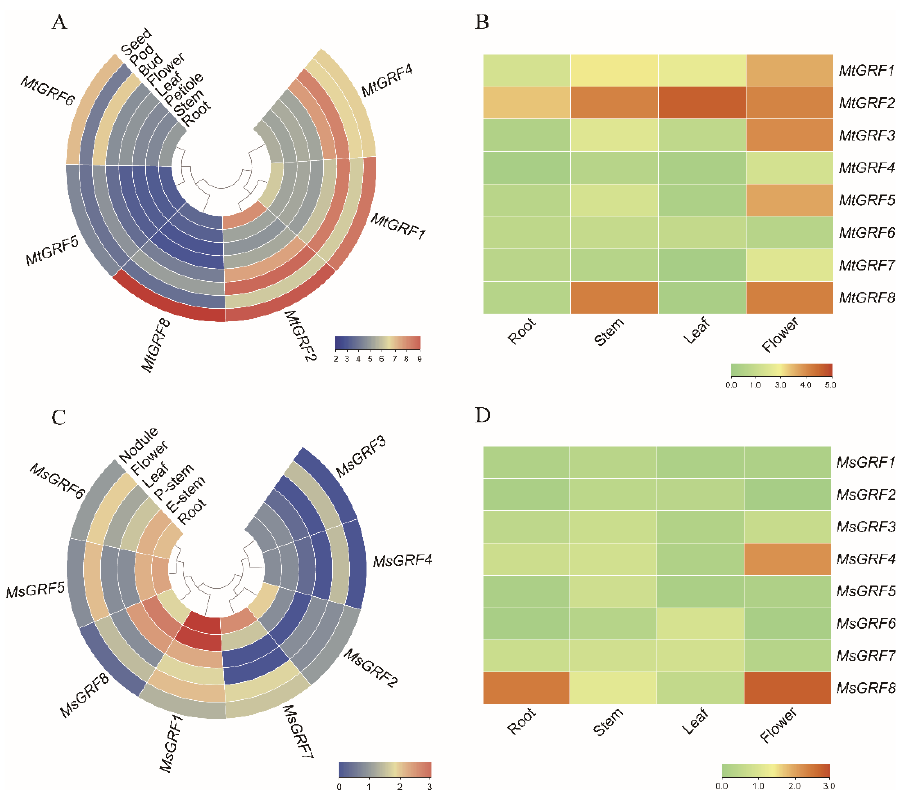
Figure 6. Expression profiles of GRF genes in various tissues. ( A , C ): Expression profiles of MtGRF and MsGRF genes in different tissues retrieved from genechip dataset and transcriptome, respectively. ( B , D ): Expression level of MtGRF and MsGRF genes in various tissues verified by qPCR. The relative expression levels are log2-transformed and visualized for heatmap. Red represents relatively high expression and blue ( A , C ) or green ( B , D ) represents relatively low expression.